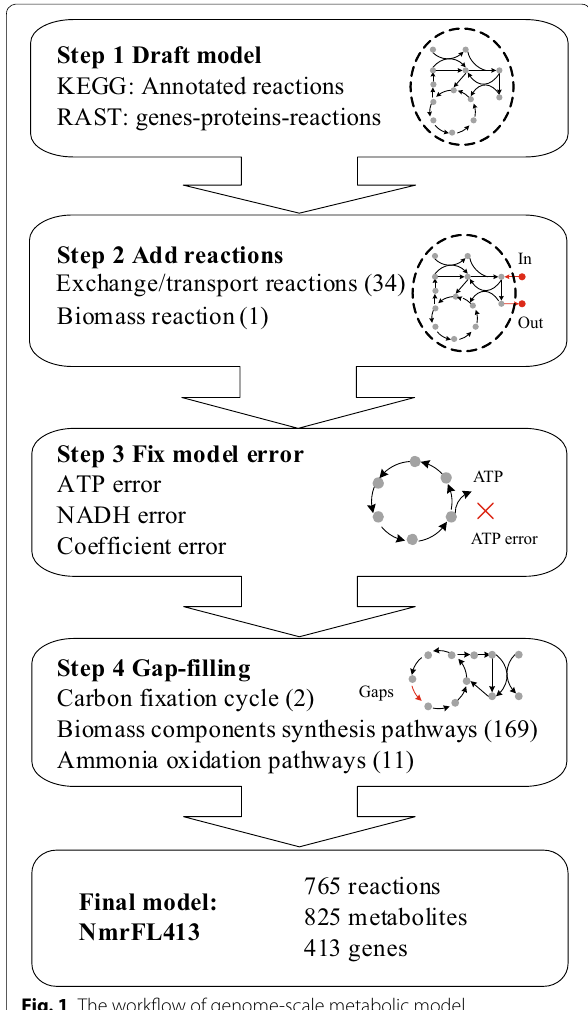
Fig. 1 The workflow of genome-scale metabolic model reconstruction of strain